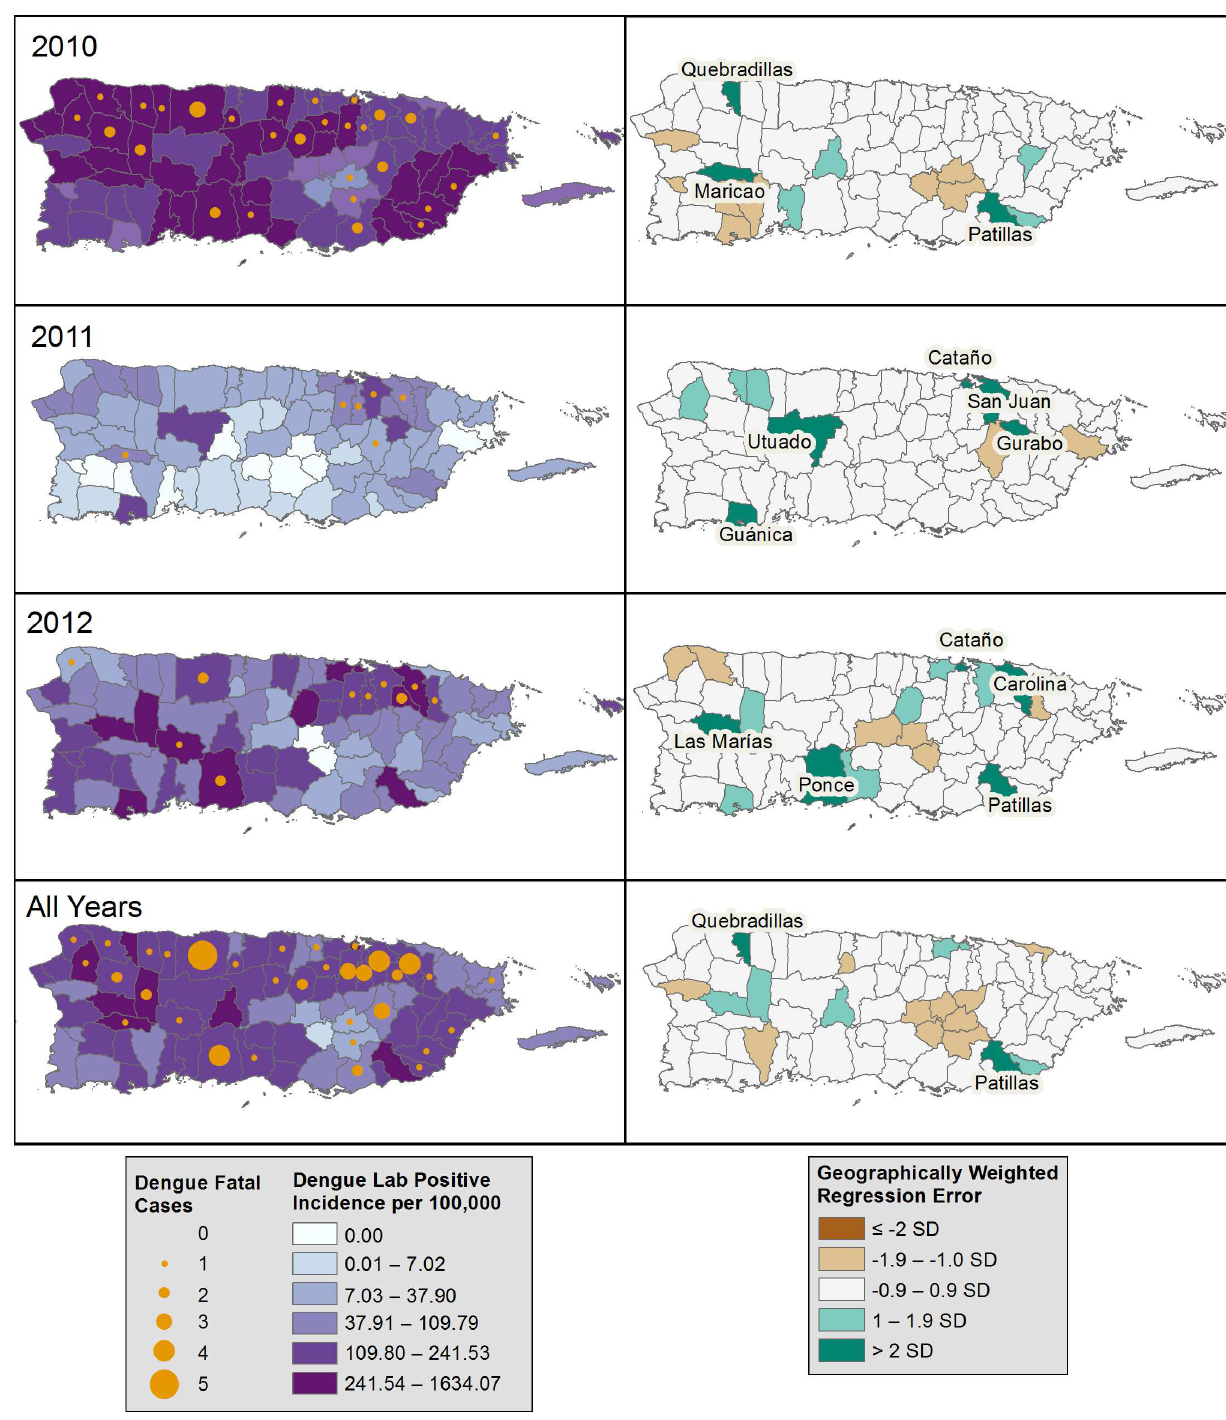
Fig 2. Incidence of laboratory-positive dengue, and observed and expected number of fatal laboratory-positive dengue cases by municipality of residence and year, Puerto Rico, 2010–2012. Left panels: Incidenceper 100,000populationof non-fatal, laboratory- positive denguecases reported to the Passive DengueSurveillanceSystem, and number of fatal laboratory-positive denguecases identified by the Enhanced Fatal AFI Surveillance System. Right panels: the standard deviation(SD) of the standard residualsare displayed. Differences > 2 SD denotes significantly fewer than expected fatal laboratory-positive denguecases, while (cid:20) 2 SD denotes significantly more than expected fatal laboratory-positive denguecases.